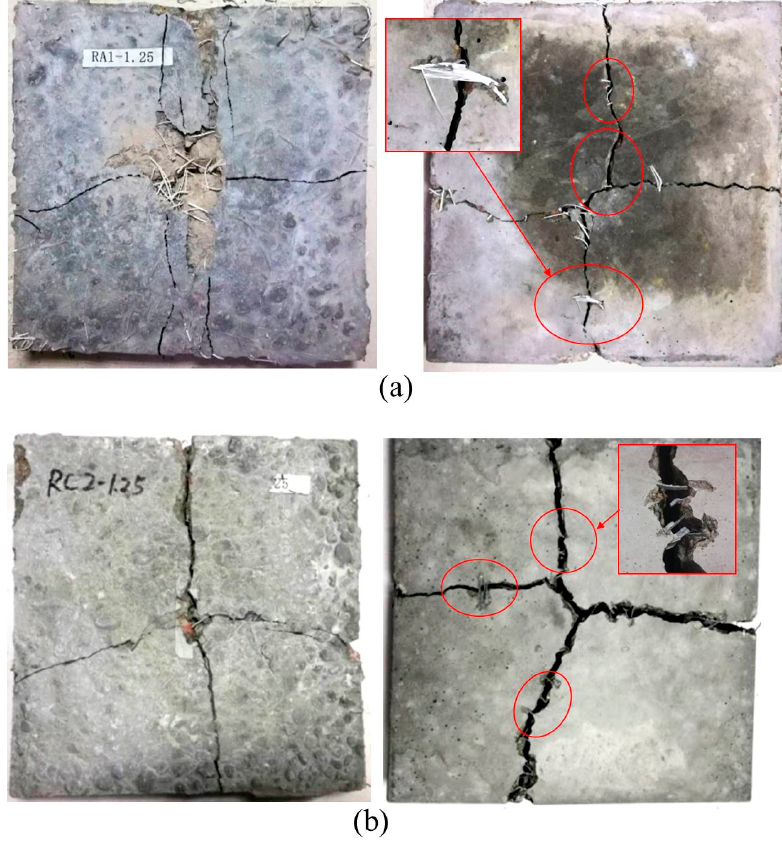
Figure 5. The comparison of impact failure modes: ( a ) HFRAC specimen (front/back); ( b ) SFRAC specimen (front/back).